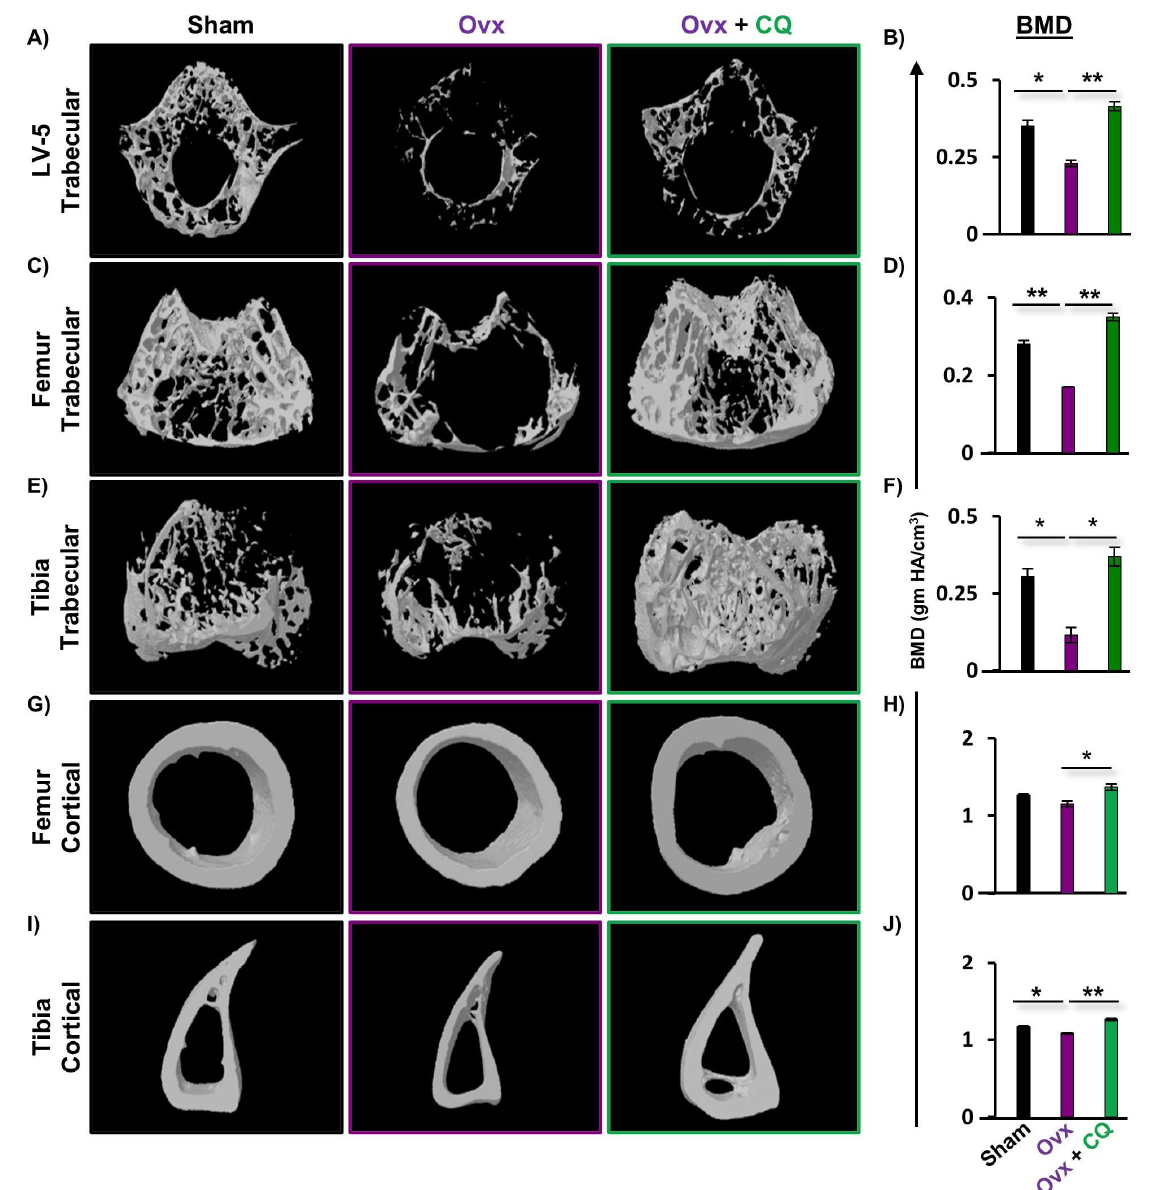
Figure 4. CQ administration improves trabecular bone microarchitecture: Three dimensional µ-CT reconstruction of LV-5 (trabecular), femur (trabecular and cortical), and tibia (trabecular and cortical) and graphical presentation of BMD (gm HA/cm 3 ) of all the following groups. ( A ) Bone microarchitecture of LV-5 trabecular region. ( B ) BMD of LV-5 trabecular. ( C ) Bone microarchitecture of femur trabecular region. ( D ) BMD of femur trabecular region. ( E ) Bone microarchitecture of the tibia trabecular region. ( F ) BMD of the tibia trabecular region. ( G ) Bone microarchitecture of the femur cortical region. ( H ) BMD of the femur cortical region. ( I ) Bone microarchitecture of the tibia cortical region. ( J ) BMD of the tibia cortical region. BV/TV; bone volume/tissue volume ratio, Tb.Th; trabecular thickness, Tb.Sp; trabecular separation, Tt.Ar; total cross-sectional area inside the periosteal envelope, Ps.Pm; periosteal perimeter, Ct.Th; average cortical thickness and BMD; bone mineral density. ANOVA was used to analyse the results, and then unpaired Student t-tests were used to compare the indicated groups. Values are expressed as mean ± SEM, and equivalent outcomes were observed in two independent experiments. For the indicated groups, p 0.05 (* p ≤ 0.05, ** p ≤ 0.01) was used as the cutoff for statistical significance. In the figure, black color is indicating control group, purple color is indicating osteoporotic group and green color is highlighting osteoporotic group treated with CQ.